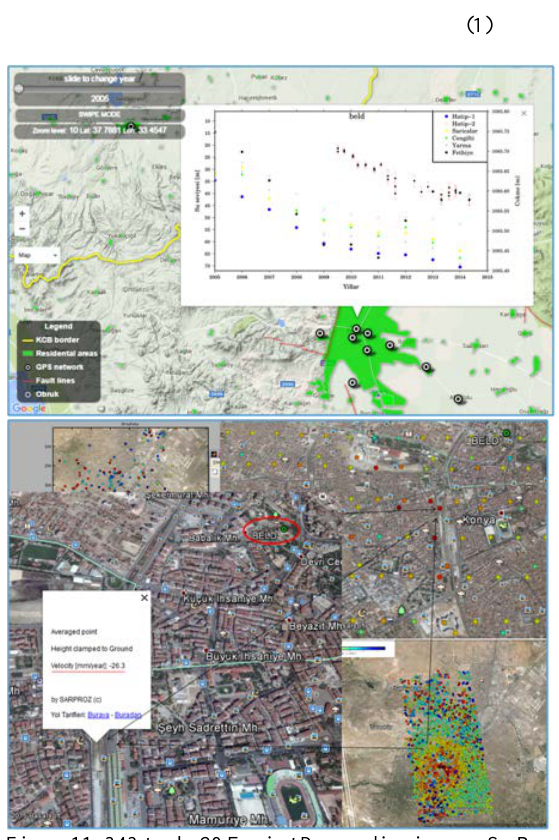
Figure 11. 343 track, 20 Envisat Descending images, SarProz PSI results, subsidence rate of PS over BELD GPS